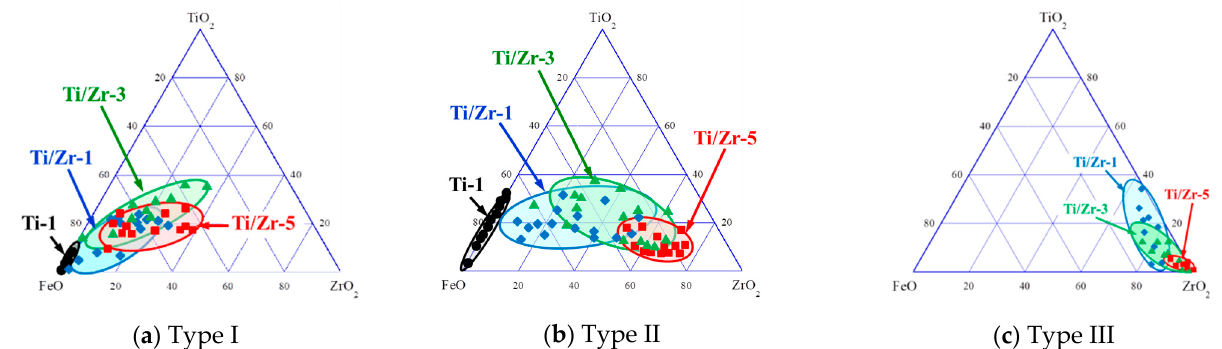
Figure 3. Changes of compositions of inclusions (Types I and II) and clusters (Type III) depending on holding time in the Ti/Zr experiments.